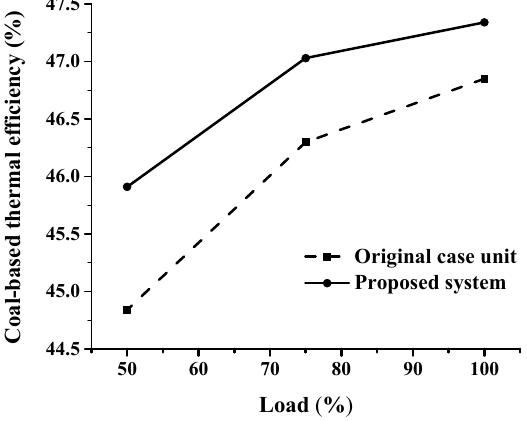
Figure 6. Coal-based thermal efficiency of the proposed system and original case unit.